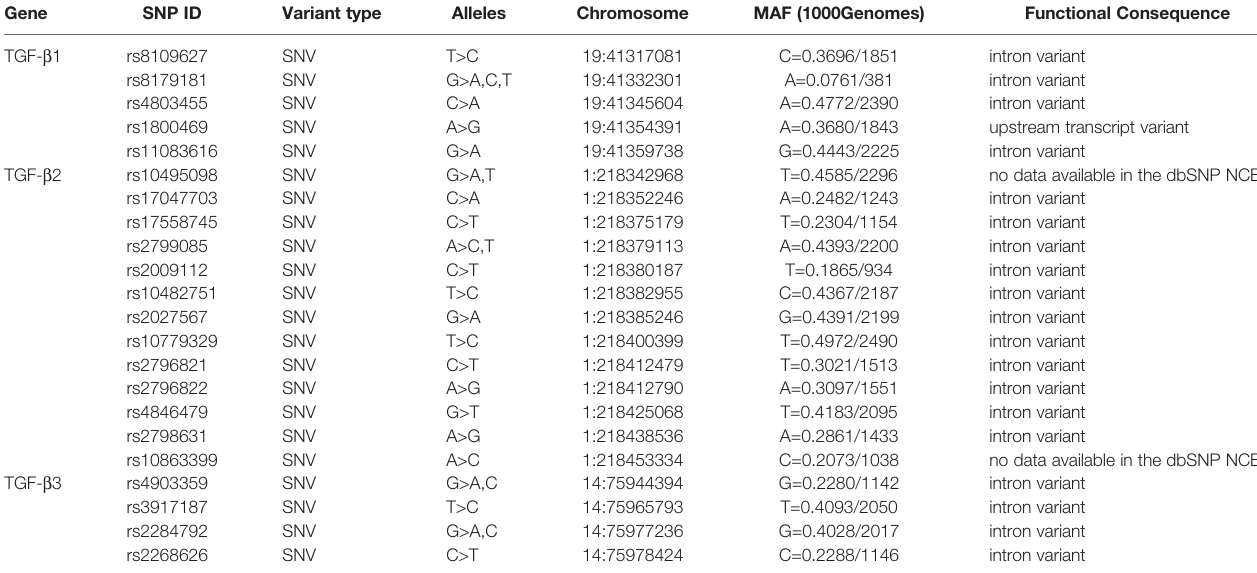
TABLE 1 | Characteristics of tagging SNP polymorphisms in TGF b 1, TGF b 2 and TGF b 3 genes on the basis of the dbSNP database of the National Center for Biotechnology Information, U.S. National Library of Medicine (8600 Rockville Pike, Bethesda MD, 20894 USA).